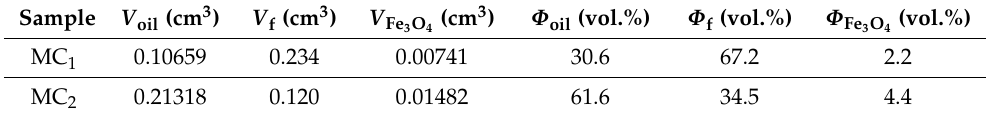
Table 2. Volumes ( V ) and volume fractions ( Φ ) of the components of the two composite materials. Sample 𝑽 𝐨𝐢𝐥 (𝐜𝐦 𝟑 )